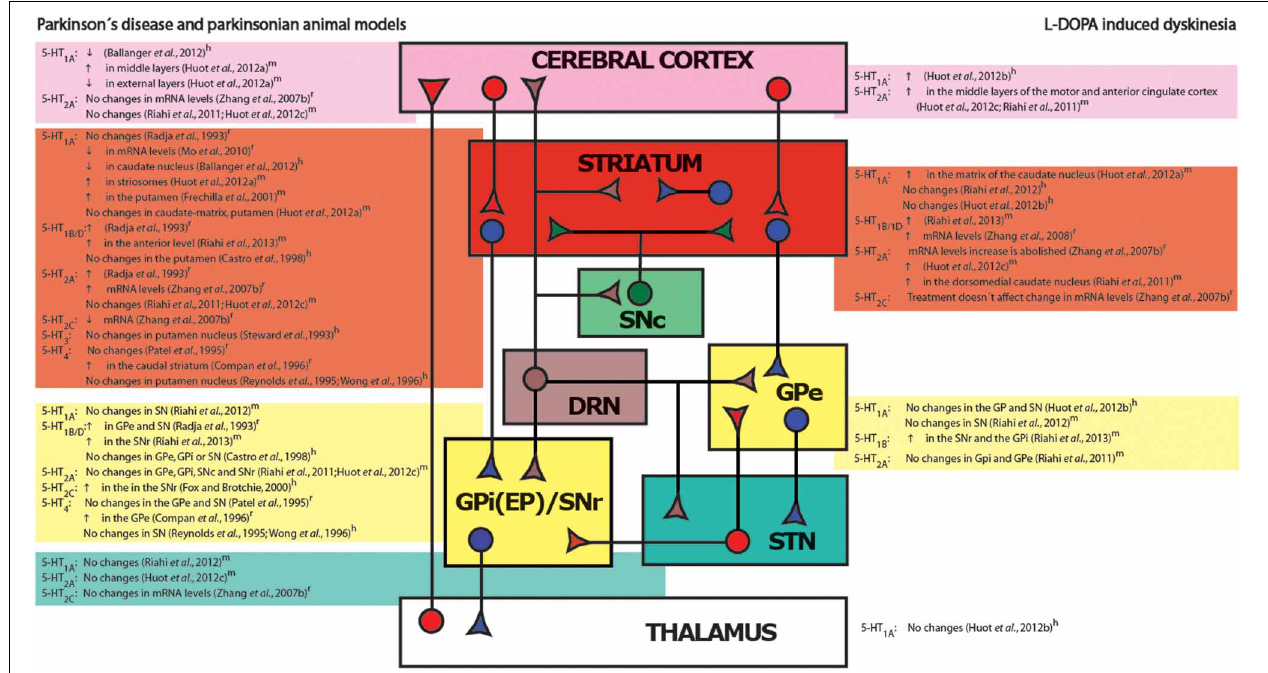
FIGURE 1 | Simplified diagram of the basal ganglia circuits and altered serotonergic receptor expression in pathological states. Changes found in serotonergic receptor density in parkinsonian (left boxes) and dyskinetic (right boxes) patients or animals models compared to control conditions. Each nucleus and its modifications in receptor expression are encoded with the same color. GABAergic inhibitory pathways are represented in dark blue and